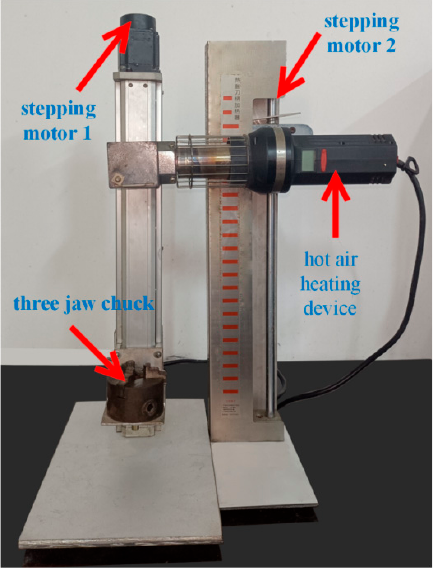
Figure 6. Numerical control shrink-fit holder clamping fatigue test device.